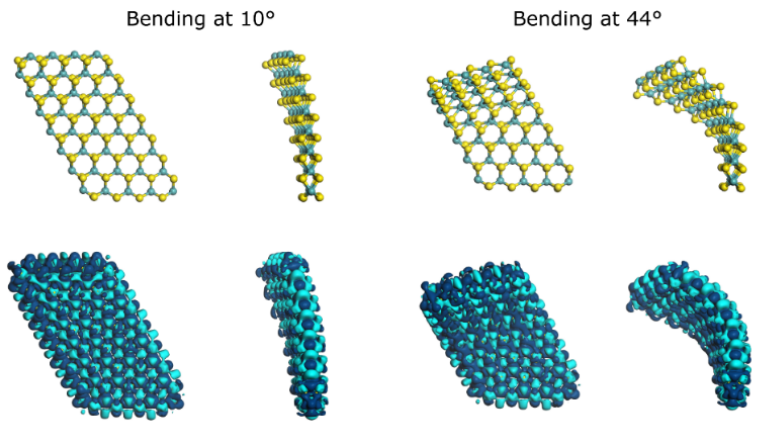
Figure 4. Projection of electron density surface for both bending curvatures angles 10° and 44°. The light blue surface represents positively charged density and navy blue represents negatively charged density. One can observe electron density is more packed as the bending curvature angle increases and the negatively charged density increases at Mo ‐ edge.